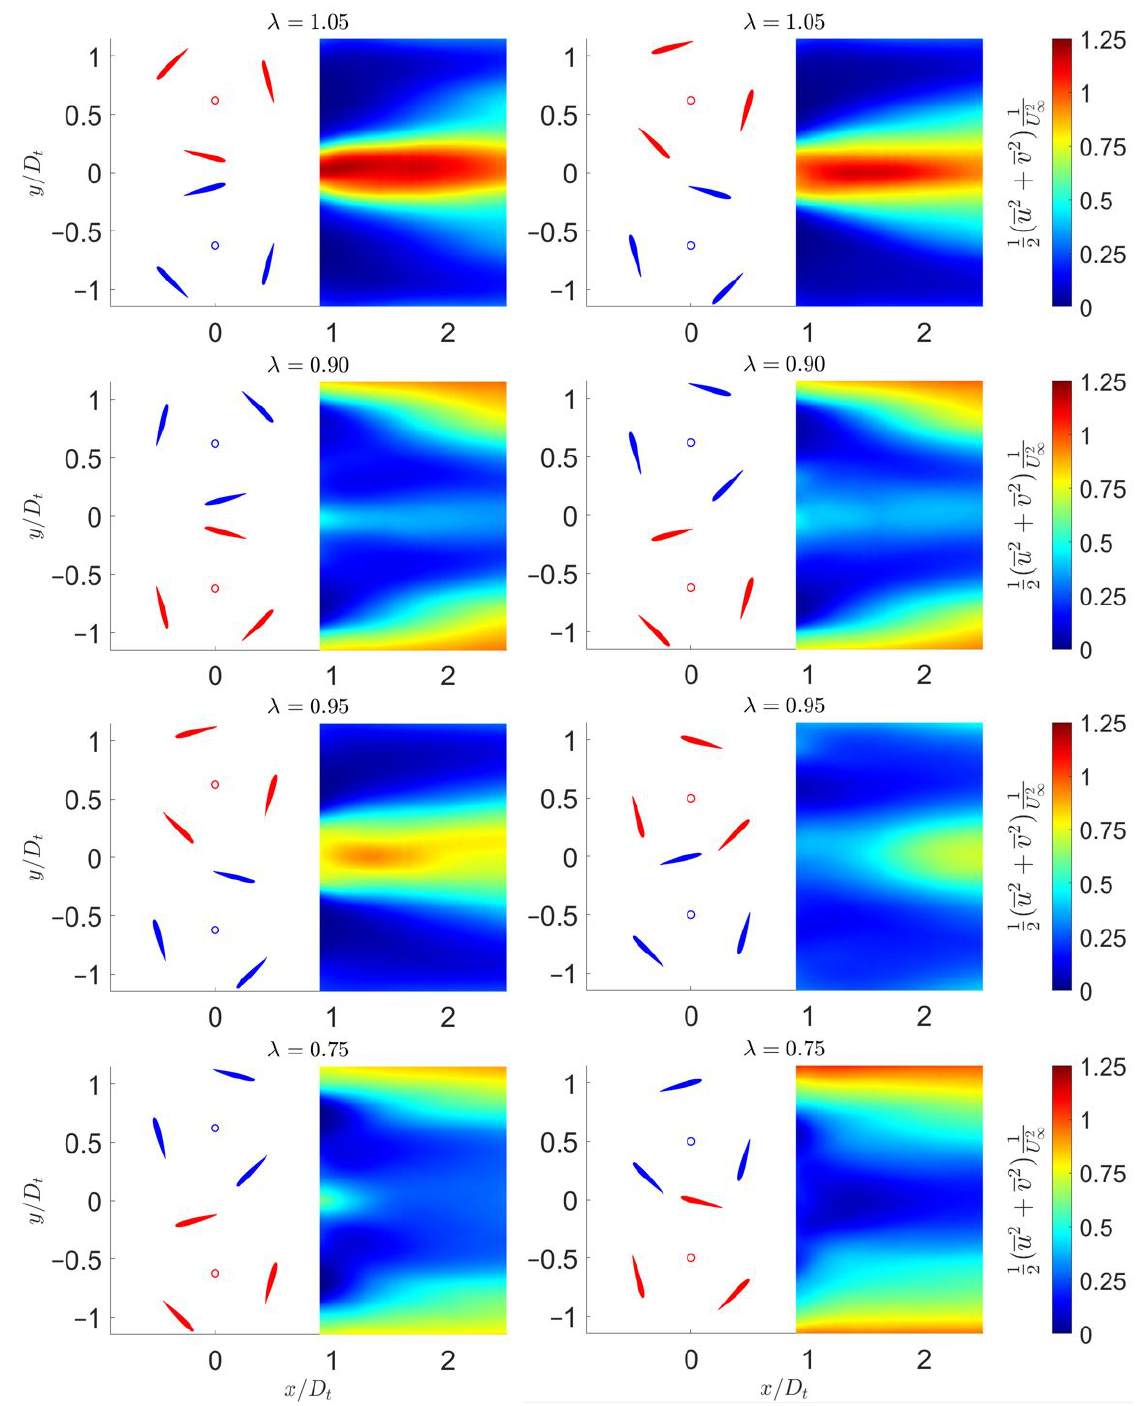
Figure 14. The time-averaged kinetic energy of the near-wakes for the cases shown in Figures